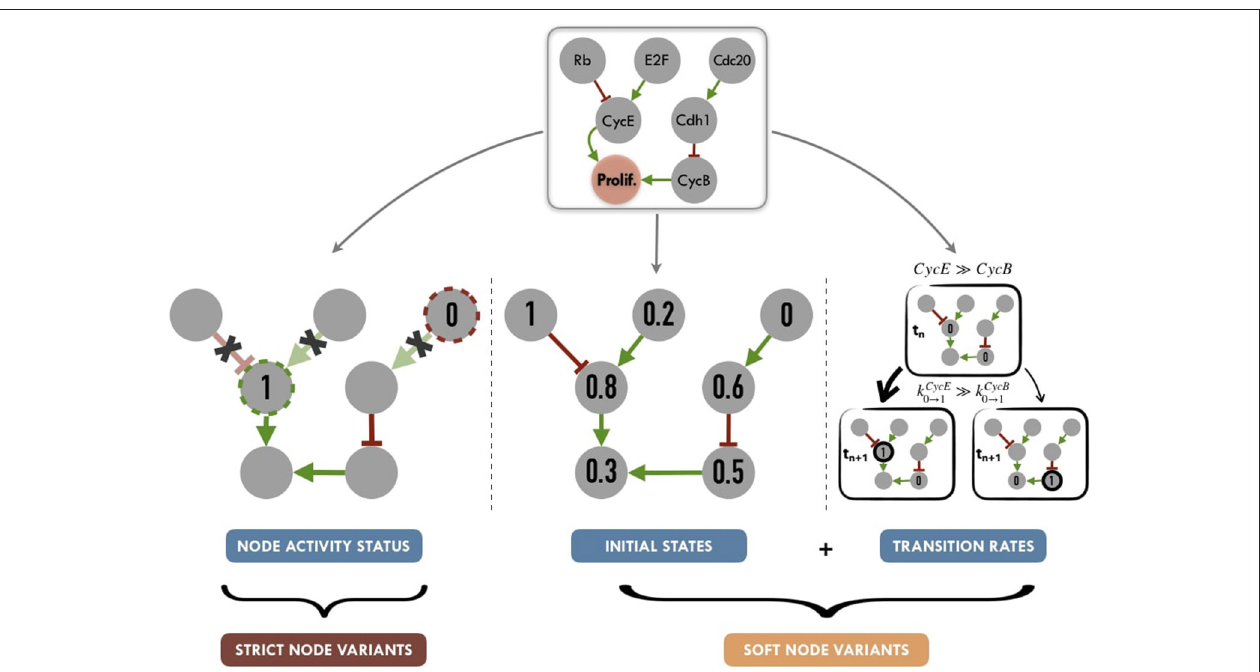
FIGURE 5 | Graphical summary of personalization methods for logical models: node activity status (nodes set to a given value for the full run of the simulation, without consideration for logical rules), initial states (nods initialized to a given proportion of 0 or 1 states) and transition rates (weighted stochastic transitions depending on the assumed activity level of nodes). Tuning node activity status, we define Strict Node Variants or Strict NV, i.e., forcing the activity (either present or absent) of a node. Tuning both initial states and transition rates, we define Soft Node Variants or Soft NV, i.e , nodes whose initial activation proportion is close to that of the patient and whose transition rates promote maintenance in its state of